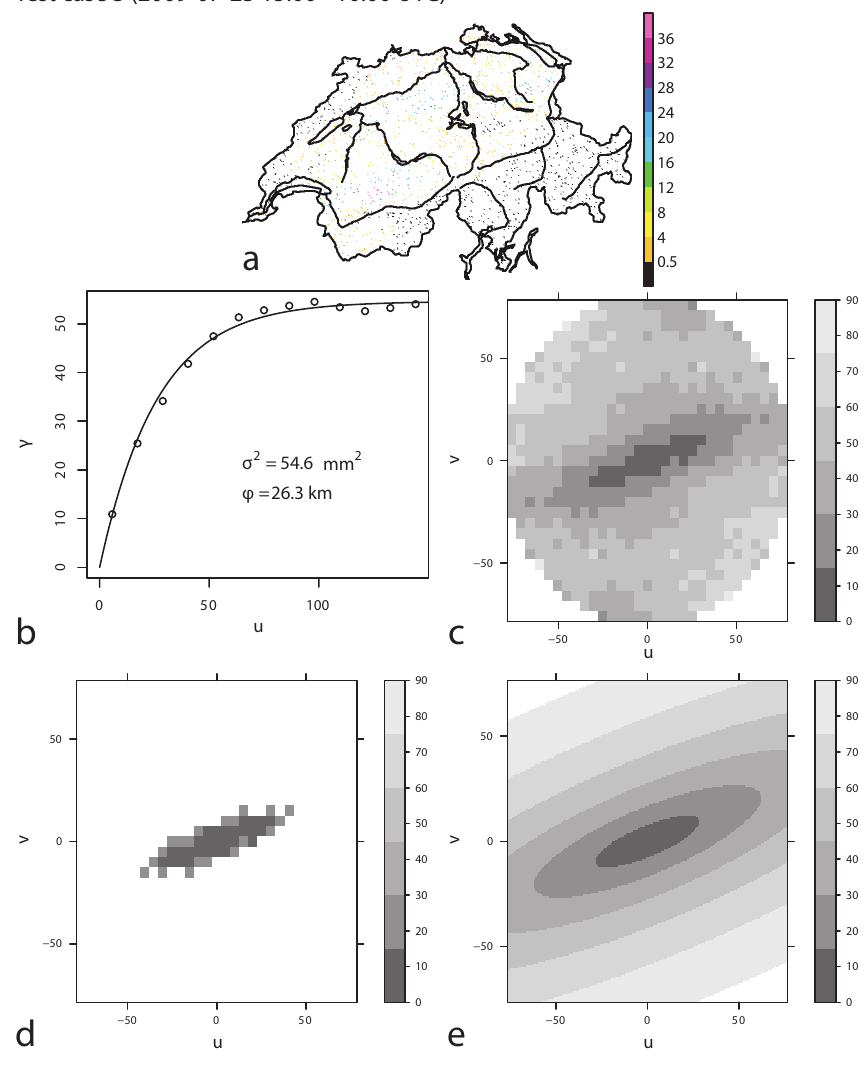
Fig. A1. Estimation of a two-dimensional parametric semivariogram. (a) Subsample of 3370 random radar pixels from the full composite of CombiPrecip test case 8 (Fig. 5f; mm). (b) First-guess one-dimensional semivariogram from the subsample, (c) two-dimensional sample variogram, (d) two-dimensional variogram restricted to small lags, (e) exponential anisotropic variogram model fitted to the central part of the sample variogram.